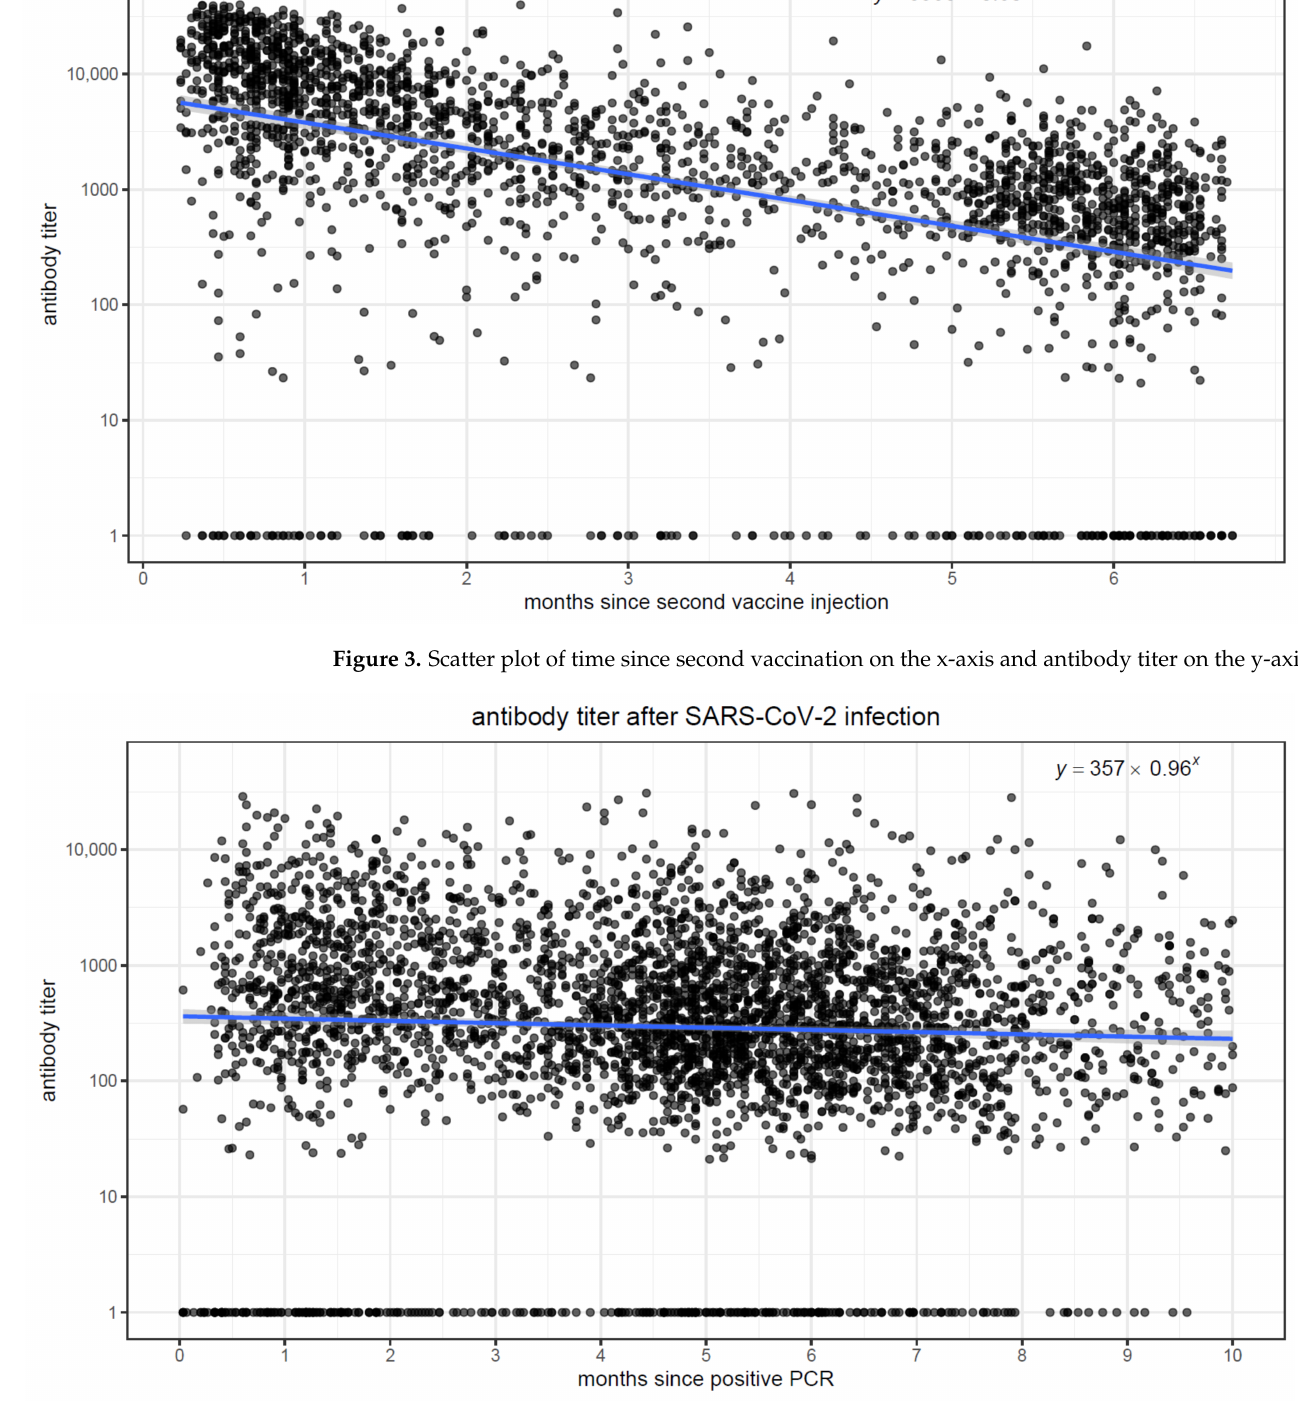
Figure 4. Scatterplot of time since infection on the x-axis and antibody titer on the